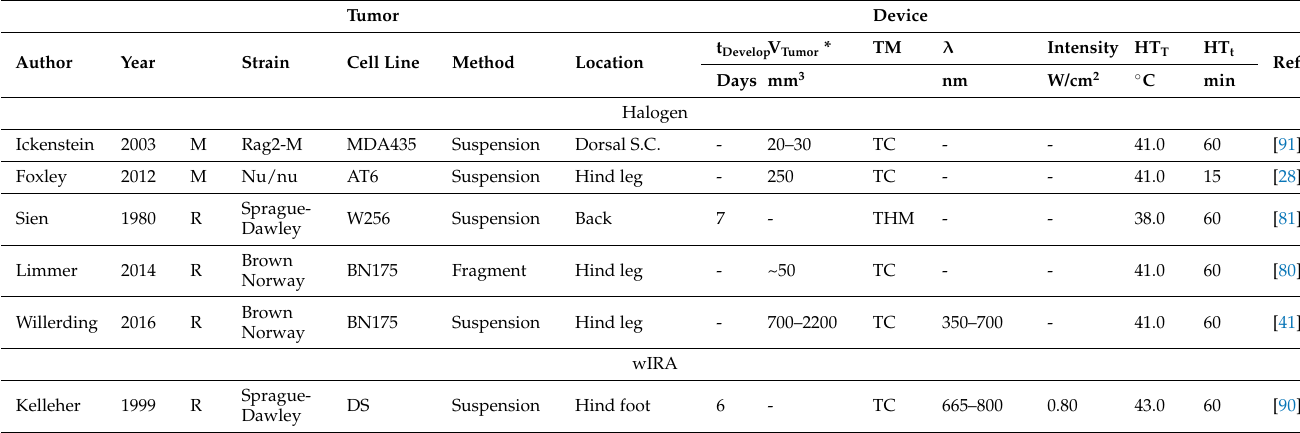
Figure 3. Illustrations of the cold light source for hyperthermia application. ( A ) The heat application through one or multiple flexible fiber optic light guides allows for relatively free positioning of the subcutaneous tumor location. The healthy tissue can be shielded from illumination by placement of, for instance, cotton wool; ( B ) the light source is placed above the target area without interference of any medium. The geometry of heat application is dependent on the width of the light beam and the distance of the light source in relation to the tumor; ( C ) the water-filtered infrared-A (wIRA) radiation system eliminates the presence of both IR-B and IR-C due to the water filter. This provides a light beam with a high penetration depth. Image C is adapted from Kelleher et al. and Vaupel et al. [76,90]. Table 2. Overview of the preclinical studies on application of local hyperthermia using a cold light source sorted by year of publication and animal model. A distinction is made between the halogen- and wIRA-based CLS systems. Tumor